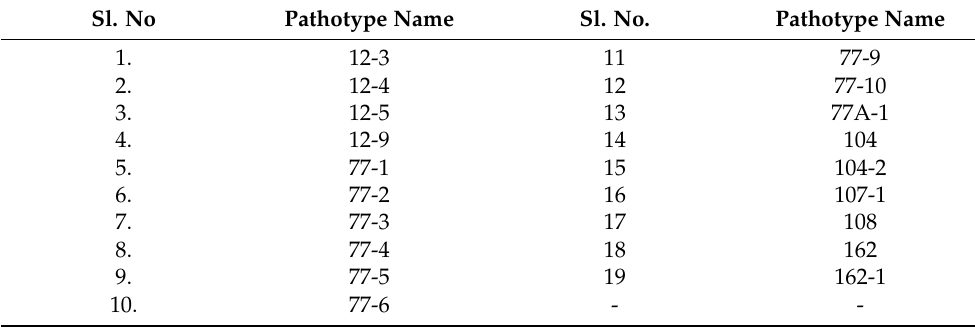
Table 3. List of leaf rust pathotypes used for screening diverse dicoccum wheat germplasm. Sl. No Pathotype Name Sl.